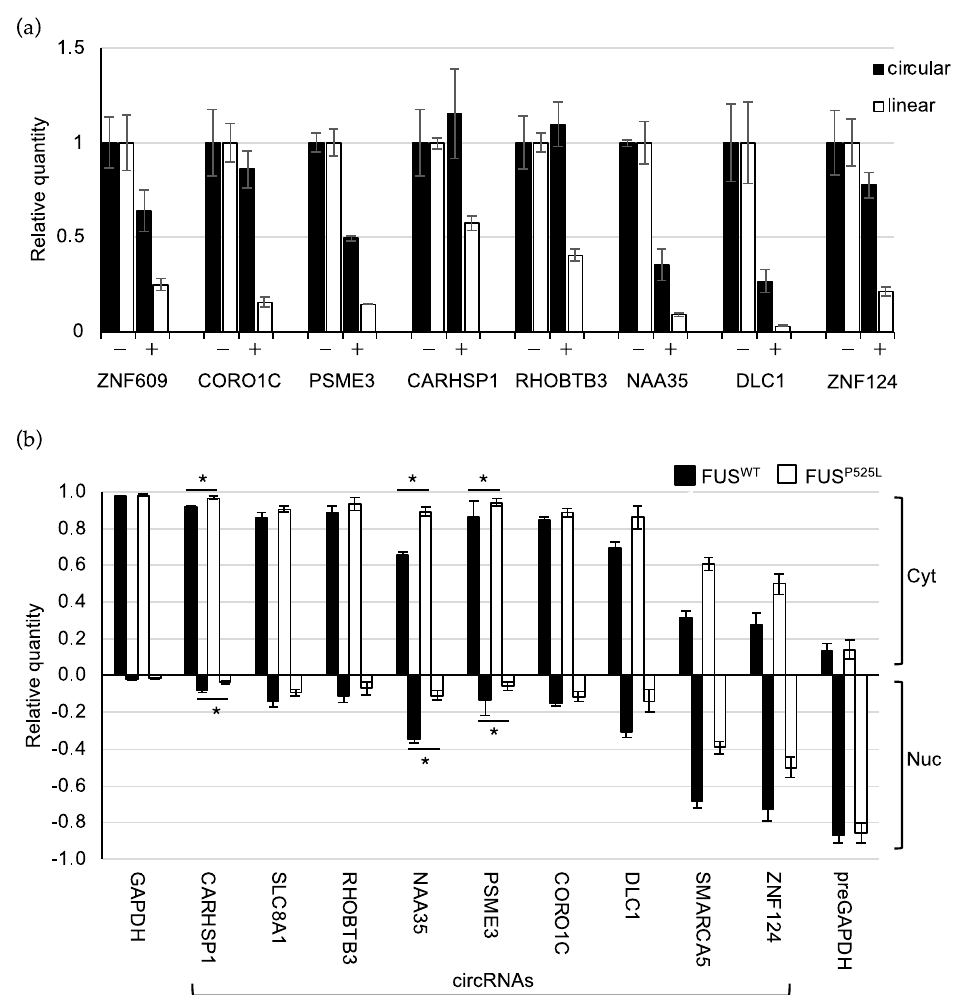
Figure 5. Circular molecules are resistant to RNaseR treatment and are mainly localized in the cytoplasm. ( a ) Bar plot showing the levels of the indicated circular and linear transcripts measured by quantitative Real-Time PCR upon the RNase R treatment ( + ) of total RNA from FUS WT mature MNs. CircRNA levels were quantified using spike DNA levels as reference and expressed as relative quantity with respect to untreated samples ( − ) set to a value of 1. Circ-ZNF609 and its linear counterpart were used as the positive control for the activity of RNase R enzyme on circular and linear transcripts. Error bars represent s.d. of two independent experiments. ( b ) Bar plot showing the levels of the indicated circRNAs measured by quantitative Real-Time PCR in nuclear (Nuc) and cytoplasmic (Cyt) compartments of FUS WT and FUS P525L mature MNs. GAPDH and preGAPDH levels are used as controls for the quality of the fraction procedure. Error bars represent s.e.m. of at least three independent experiments. p -values were calculated using paired two-tailed Student’s t -test (* p < 0.05).